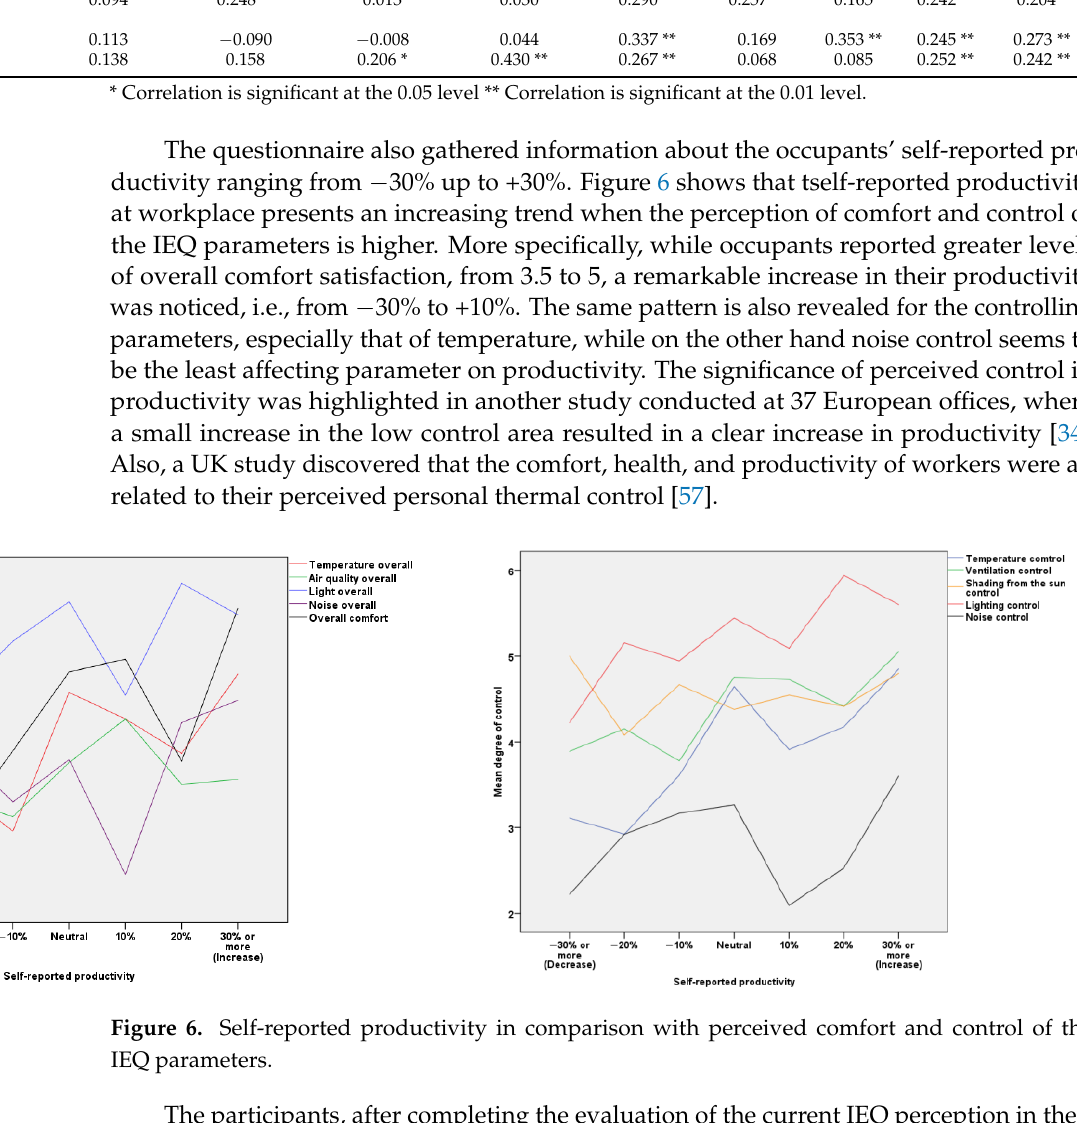
Table 2. Correlations between perceived control with exercise control and perceived comfort.